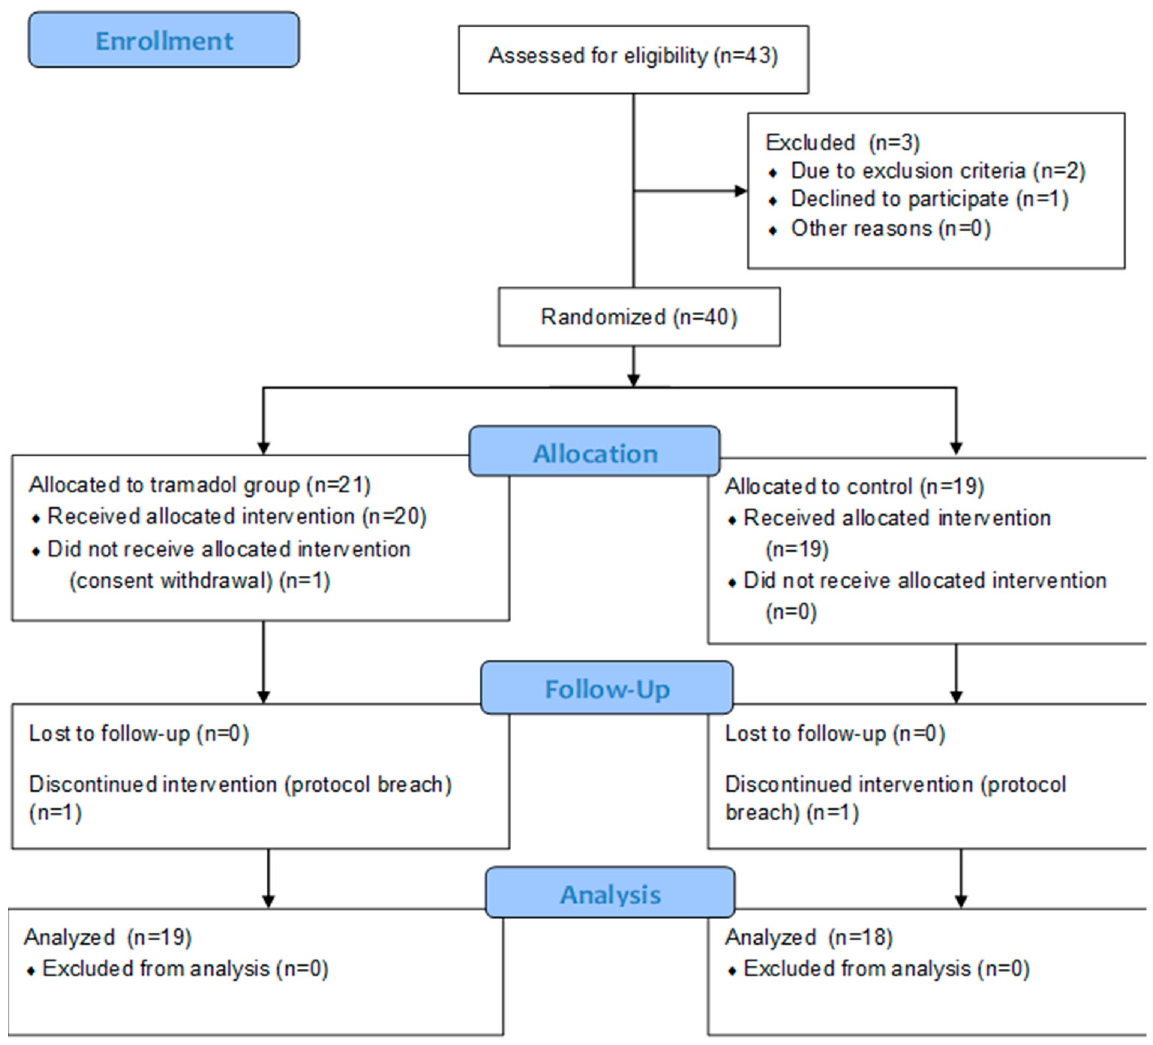
Figure 1. CONSORT flowchart.